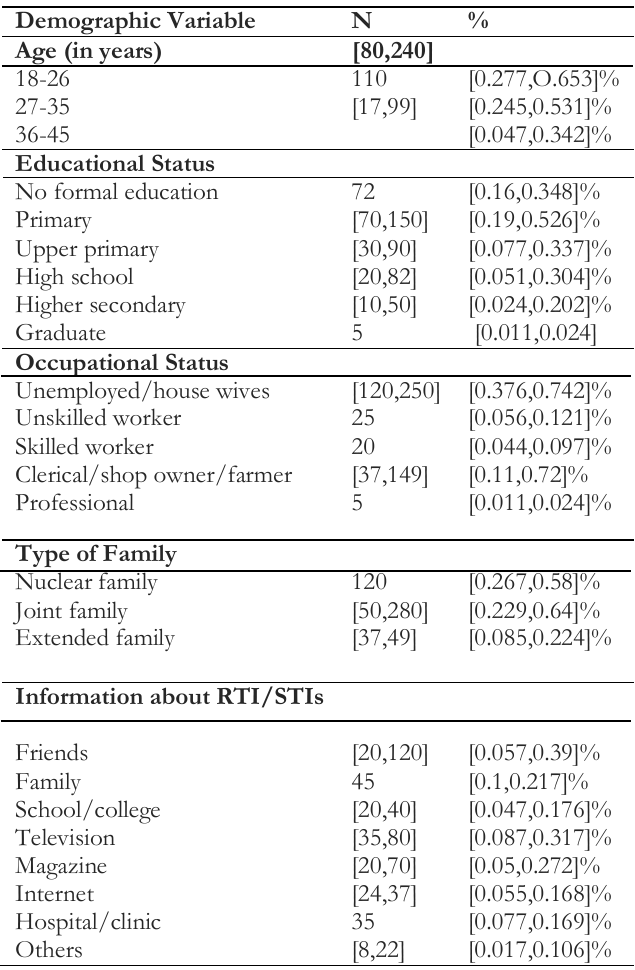
Table 2. Distribution of women according to their demographic